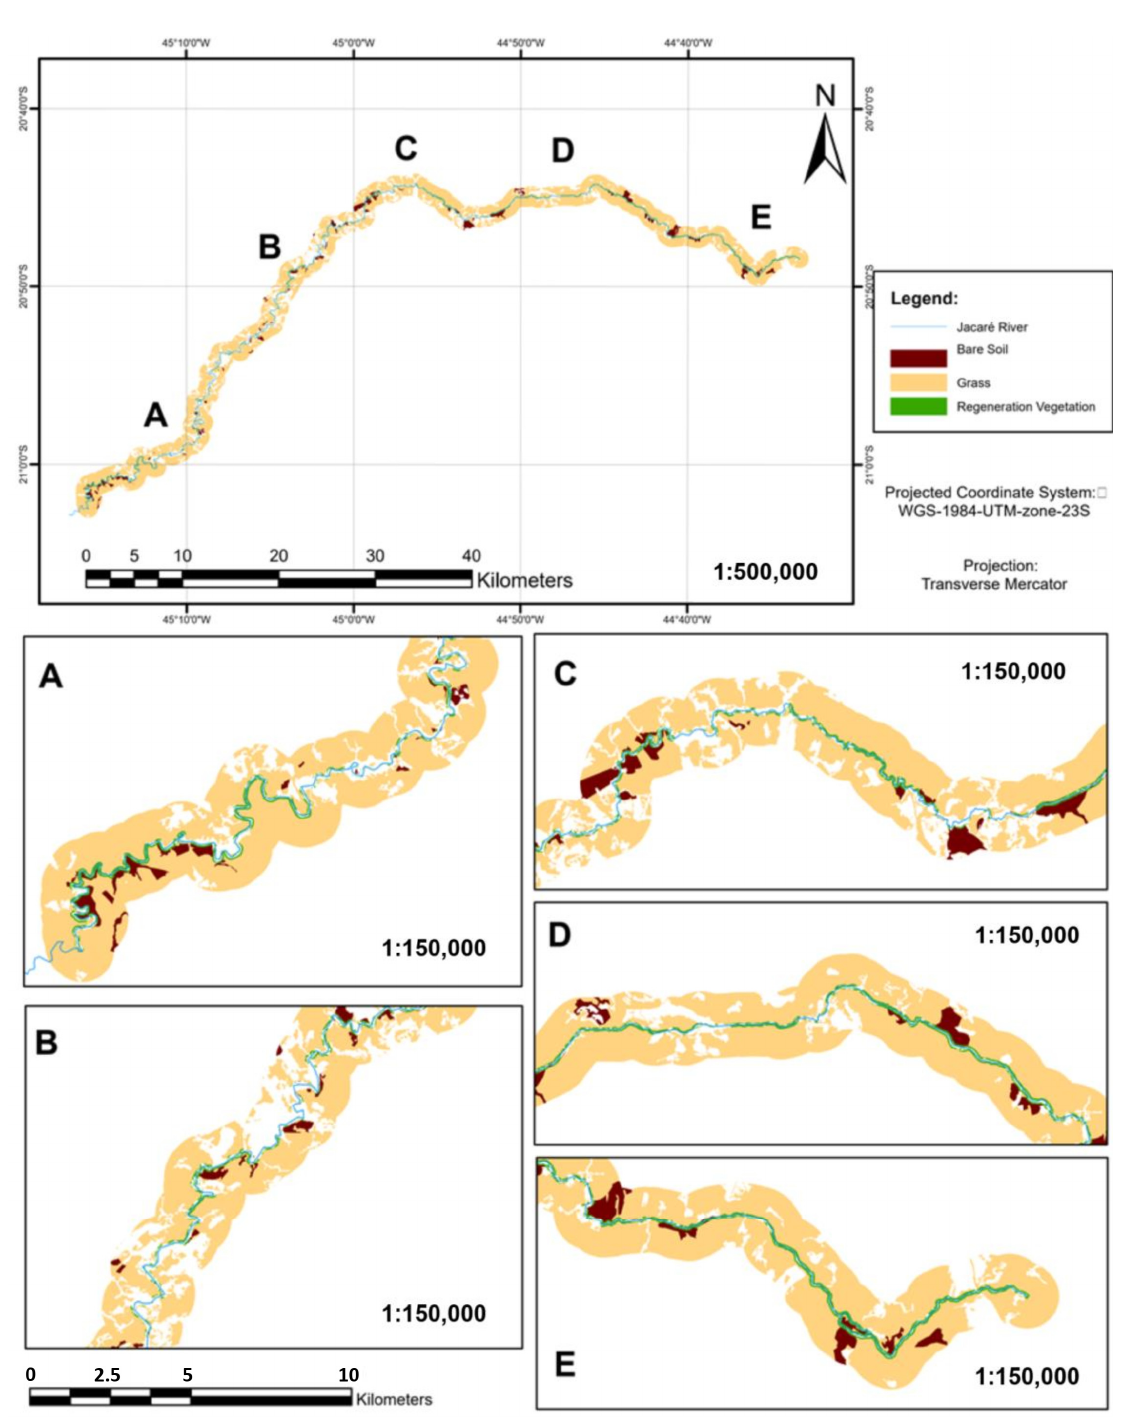
Figure 8. Vegetation map. ( A – E ) are the regions with the most significant potential for reforestation. The spatial pattern was classified into three classes. The first class is composed of Capoeira or forest in the initial stage of regeneration, covering approximately 6% of the study area. These areas have semi-dense shrub vegetation originating from the natural regeneration of abandoned agricultural areas. This vegetation attributes moisture and fertility to the planting of forest seedlings and contributes to protecting seedlings against water loss [93,94]. The second class corresponds to pasture that occupies 90% of the total coverage. This type of vegetation is associated with extensive livestock activities. They are areas with herbaceous vegetation with a predominance of grasses and legumes with relative humidity and soil fertility. The third class, represented by bare soil, occupies 45% of the study area and has many mineral aggregates on its surface. They are devoid of